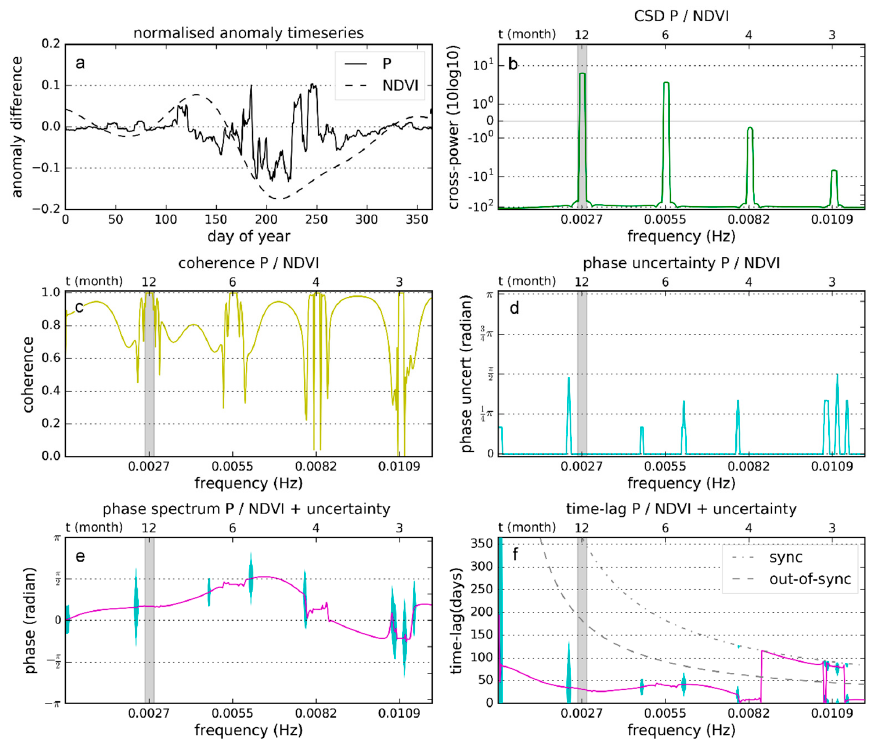
Figure 7. Procedure and intermediate results to estimate the time lag of the annual frequency (0.0027 Hz). ( a ) nomalised anomaly timeseries; ( b ) CSD P/NDVI; ( c ) coherence P/NDVI; ( d ) phase uncertainly P/NDVI; ( e ) phase spectrum P/NDVI + uncertainty; ( f ) time-lag P/NDVI + uncertainty. The cross-spectrum ( b ) and coherence ( c ) are computed using the standardized precipitation and NDVI anomaly ( a ). Using the cross-spectrum, the phase spectrum ( e ) and time lag ( f ) are obtained and the phase uncertainty ( d ) provides the distribution of the phase spectrum.